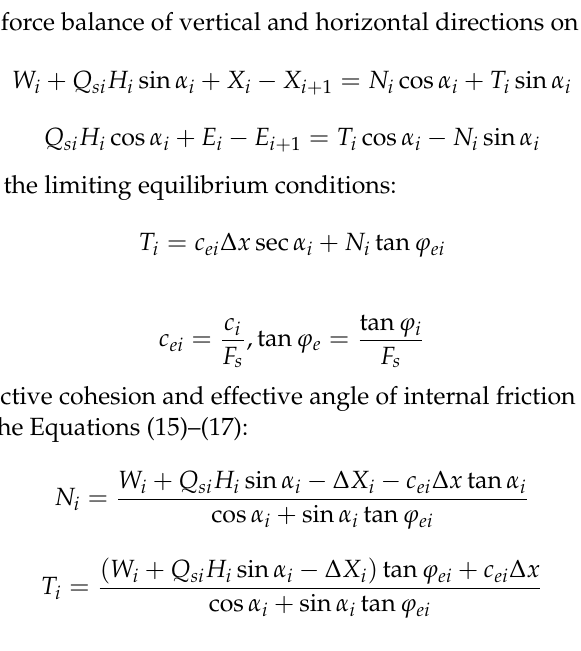
Figure 5. The slice of saturated fine-grained